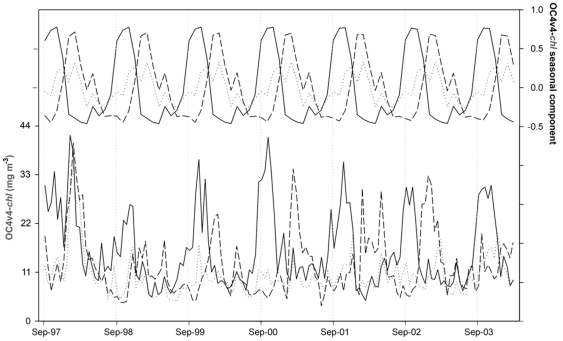
Bio-optical variability in Lake Victoria for the 1997–2004 period.OC4v4-chl time series for different lake Regions (bottom) and their corresponding seasonal components (top). North Region, solid line; Transitional Region, dotted line; South Region, dashed line.